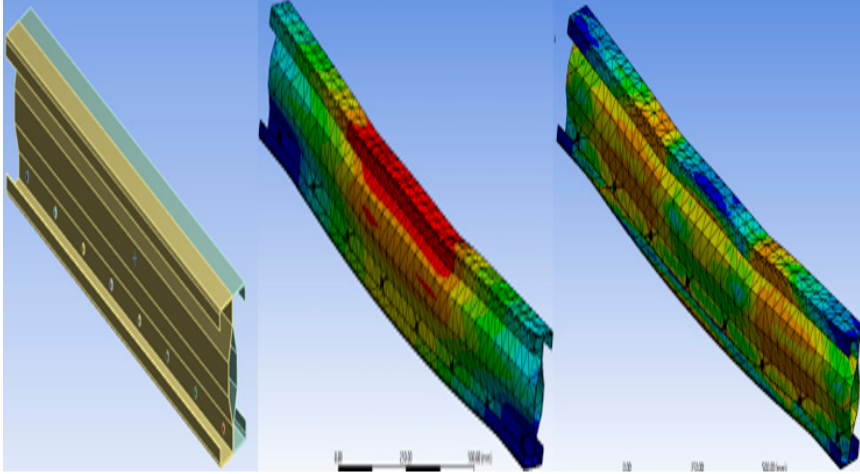
Figure 5. Buckling and stress distribution of B2B157.